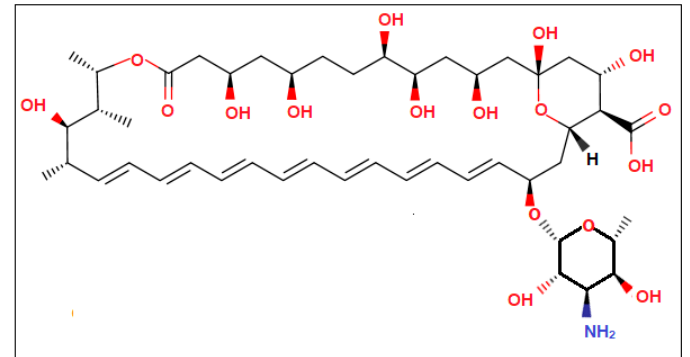
Figure 2. Chemical structure of Amp B representing its functional groups.